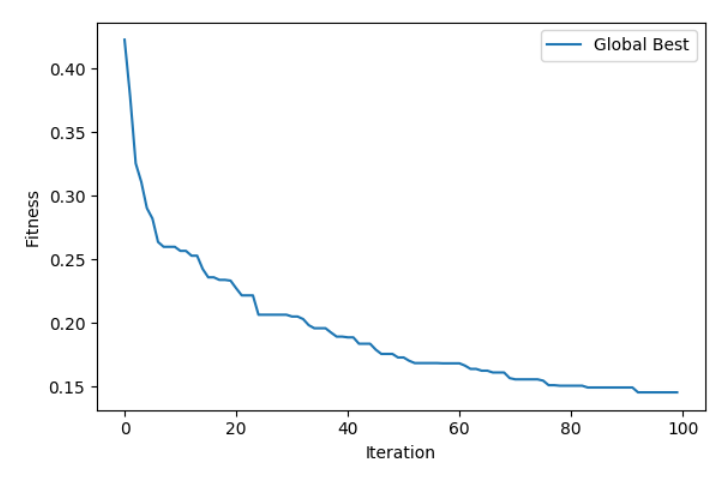
Figure 10. Fitness value of the global best particle throughout the optimisation process using the BLSK-S weight inheritance method.